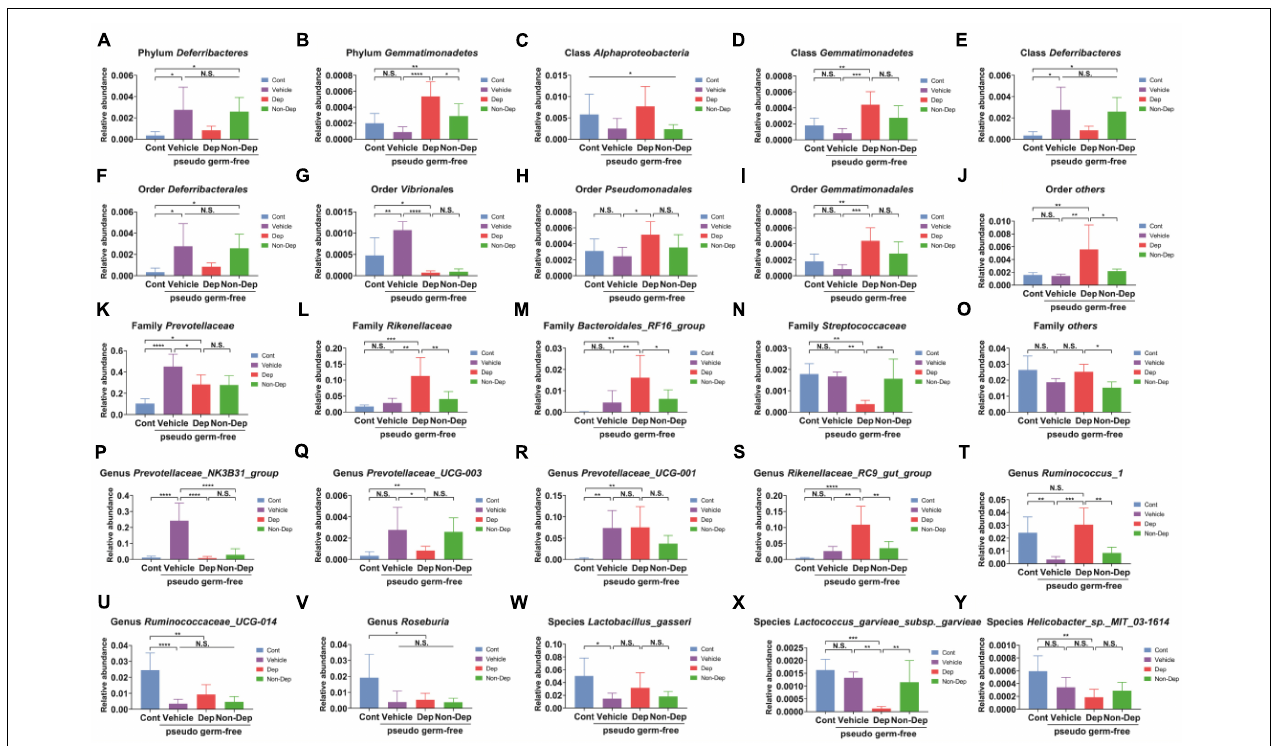
FIGURE 10 | Differences in the relative abundance of various gut microbes among Cont, Vehicle, Dep, and Non-Dep rats. (A) Phylum Deferribacteres (F3, 20 = 5.505, p < 0.05). (B) Phylum Gemmatimonadetes (F3, 20 = 11.48, p < 0.05). (C) Class Alphaproteobacteria (F3, 20 = 3.181, p < 0.05). (D) Class Gemmatimonadetes (F3, 20 = 9.061, p < 0.05). (E) Class Deferribacteres (F3, 20 = 5.505, p < 0.05). (F) Order Deferribacterales (F3, 20 = 5.505, p < 0.05). (G) Order Vibrionales (F3, 20 = 23.98, p < 0.05). (H) Order Pseudomonadales (F3, 20 = 3.670, p < 0.05). (I) Order Gemmatimonadales (F3, 20 = 9.061, p < 0.05). (J) Other orders (F3, 20 = 6.168, p < 0.05). (K) Family Prevotellaceae (F3, 20 = 15.32, p < 0.05). (L) Family Rikenellaceae (F3, 20 = 10.79, p < 0.05). (M) Family Bacteroidales_RF16_group (F3, 20 = 6.924, p < 0.05). (N) Family Streptococcaceae (F3, 20 = 8.771, p < 0.05). (O) Other families (F3, 20 = 5.736, p < 0.05). (P) Genus Prevotellaceae_NK3B31_group (F3, 20 = 22.83, p < 0.05). (Q) Genus Prevotellaceae_UCG-003 (F3, 20 = 5.505, p < 0.05). (R) Genus Prevotellaceae_UCG-001 (F3, 20 = 6.673, p < 0.05). (S) Genus Rikenellaceae_RC9_gut_group (F3, 20 = 12.28, < 0.05). (T) Genus Ruminococcus_1 (F3, 20 = 11.46, p < 0.05). (U) Genus Ruminococcaceae_UCG-014 (F3, 20 = 12.73, p < 0.05). (V) Genus Roseburia (F3, 20 = 4.602, p < 0.05). (W) Species Lactobacillus_gasseri (F3, 20 = 4.269, p < 0.05). (X) Species Lactococcus_garvieae_subsp._garvieae (F3, 20 = 10.62, p < 0.05). (Y)